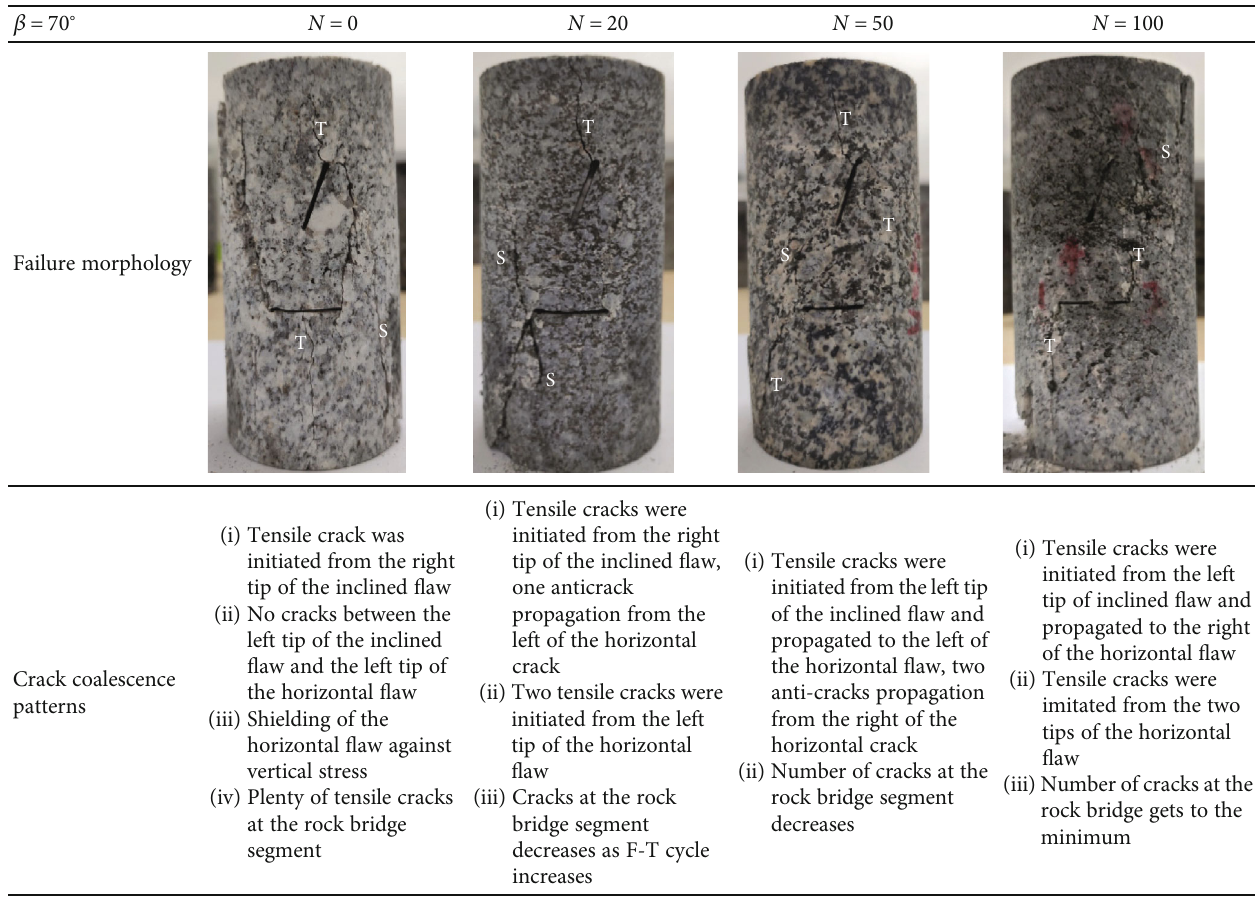
Table 4: Crack propagation and coalescence for the samples with an inclination fl aw of 70 °